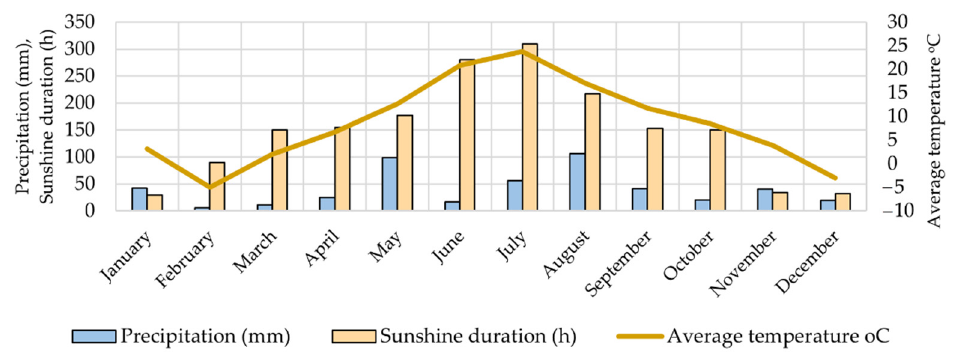
Figure 7. General climatic condition (temperature, precipitation, and sunshine duration) in Vilnius region during 2021.